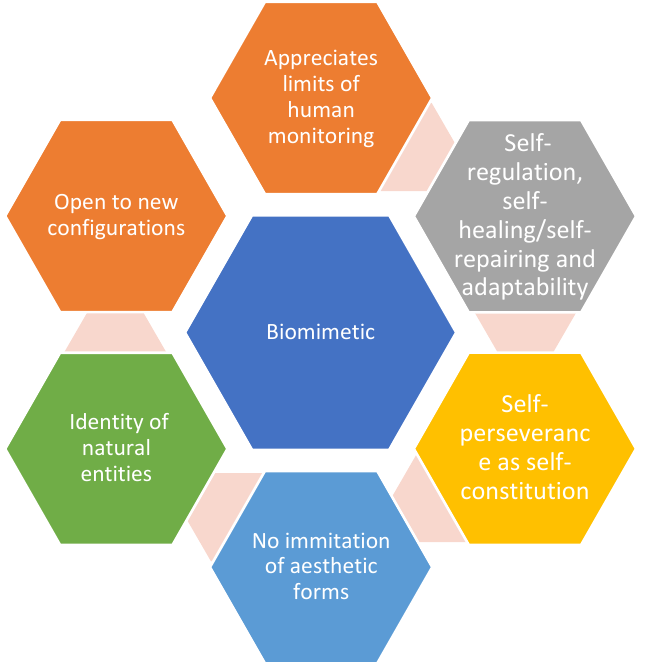
Figure 1. Unique attributes of biomimetics and contributions to agriculture and nature conservation [12].